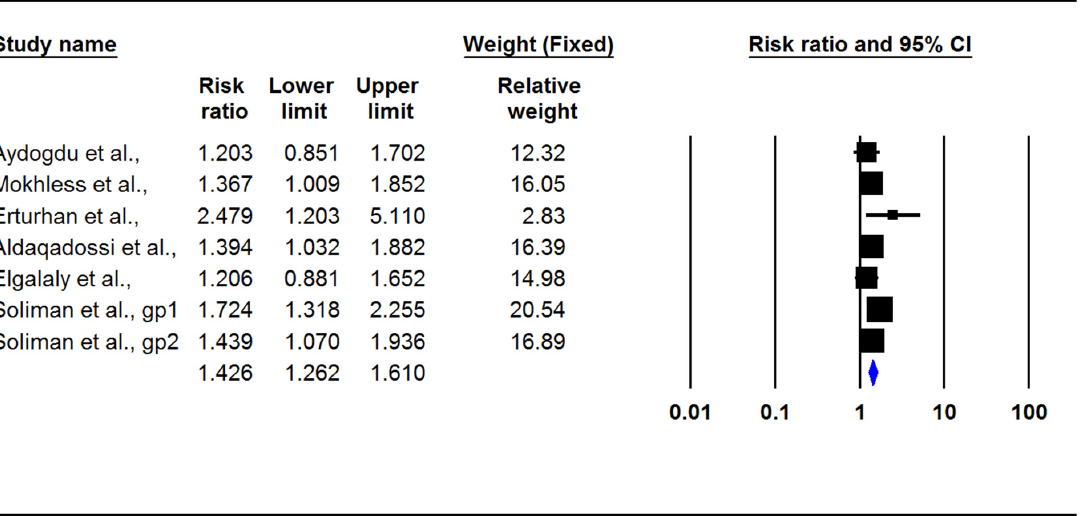
7 of 13 Figure 2. Risk of bias in included studies. A green circle indicates a low, a yellow circle indicates a moderate, a red circle indicates a critical, and a blue circle indicates an unknown level of bias [3,12– 16]. 3.3. Treatment Outcomes The present meta ‐ analysis indicated that medical treatment in children with ureteral stones could significantly increase the stone expulsion rate (RR: 1.42; 95% CI: 1.26–1.61, p < 0.001, I2: 4.42, Figure 3) and also significantly decrease the stone expulsion time (differ ‐